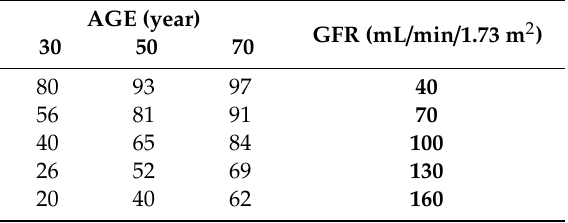
Table 4. Probability (%) to achieve a target AUC / minimum inhibitory concentration (MIC) = 100 for a